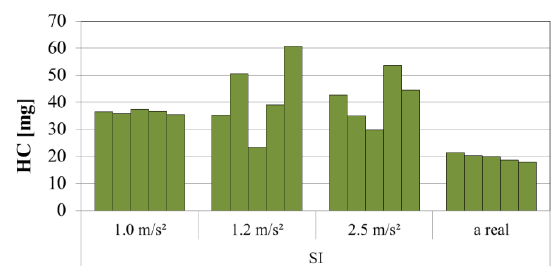
Fig. 15. HC emission for different acceleration characteristics of a vehicle propelled with SI Euro 3 engine obtained during simulation using PTV Vissim software